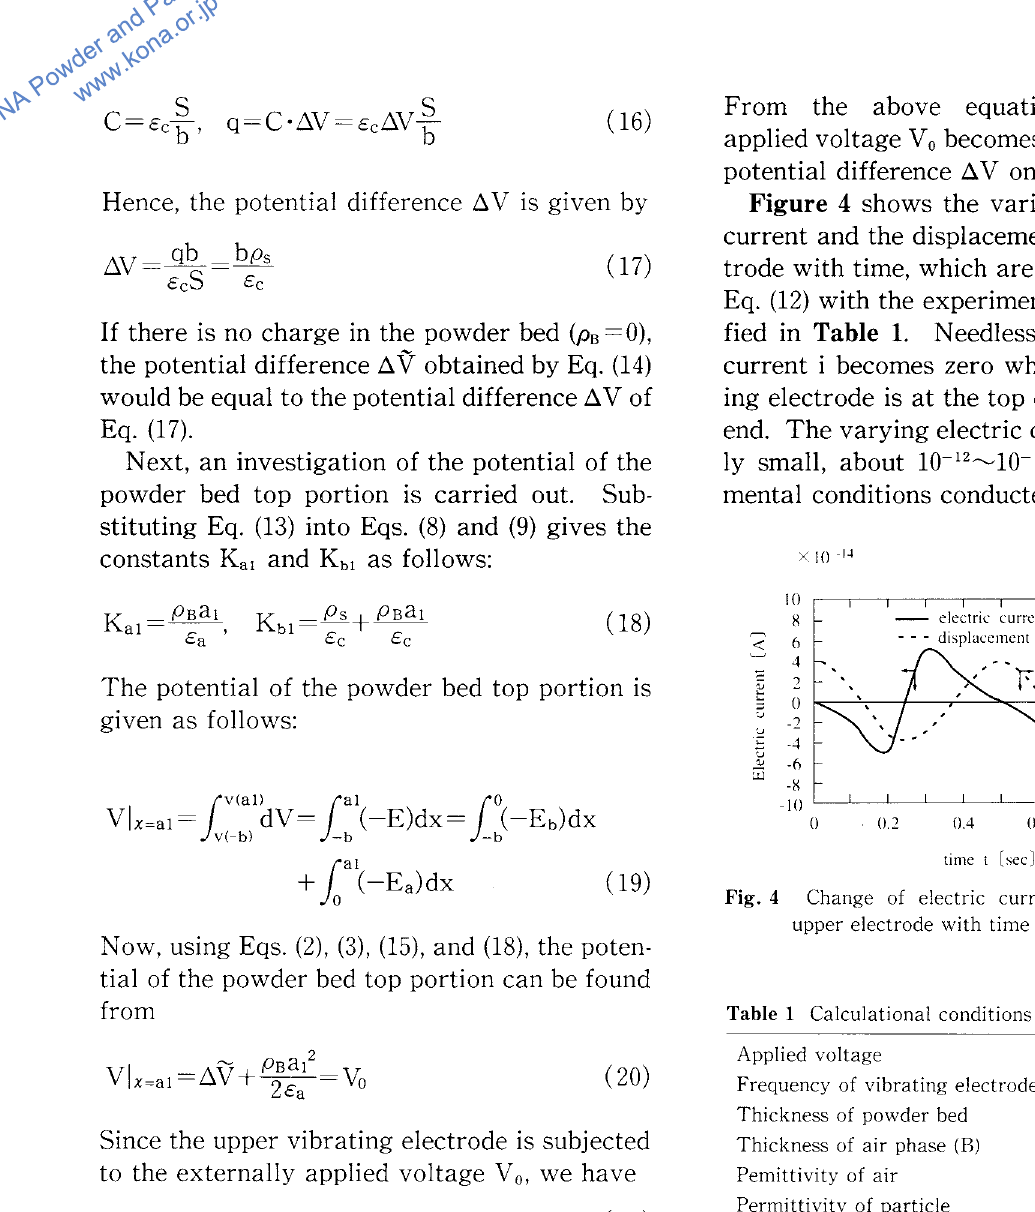
Change of electric current and displacement of upper electrode with